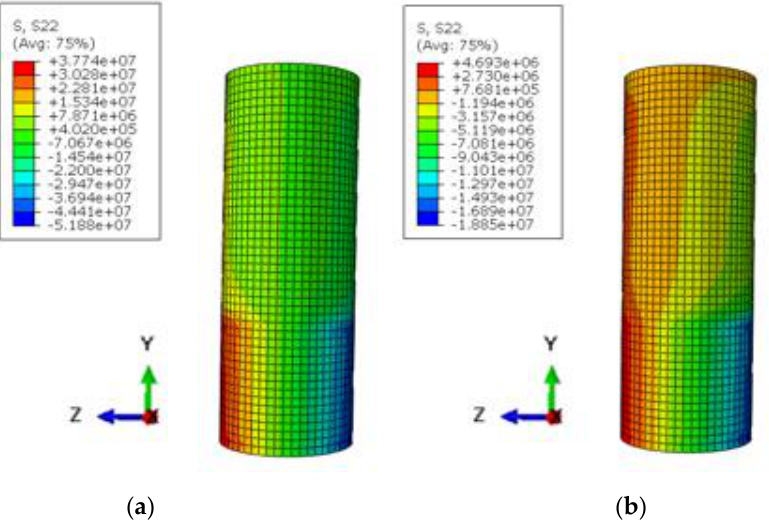
Figure 20. Vertical stresses on monopile: ( a ) Extreme sea state, ( b ) Normal conditions.